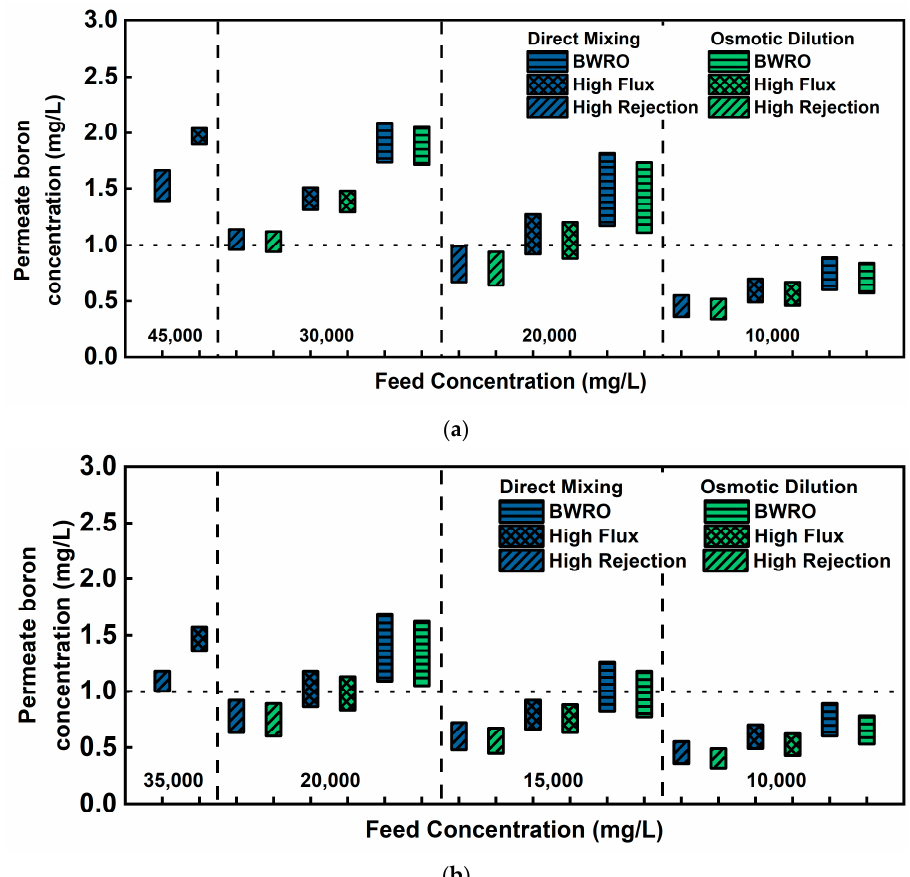
Figure 3. Variation of permeate boron concentration in the final product by process configuration, feed concentration, and membrane types in ( a ) Arabian Gulf seawater and ( b ) average seawater.